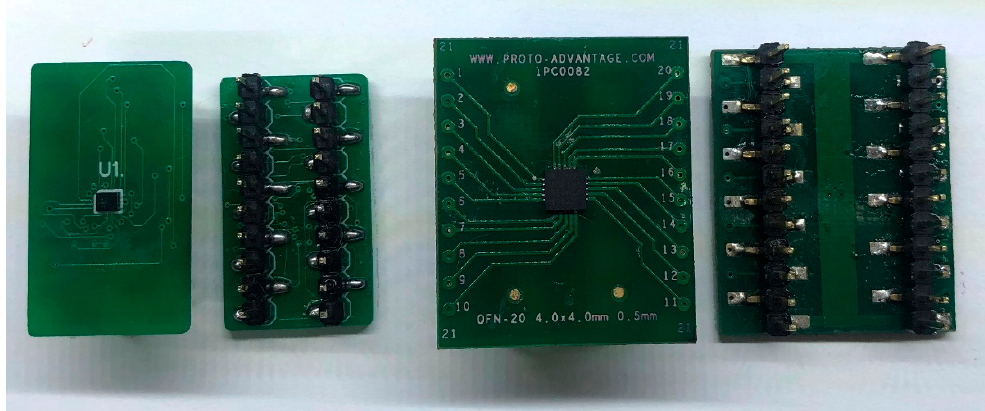
Figure 4. SMD-DIP (breadboard) Adapter for AD8232 and AD8233 microchips.